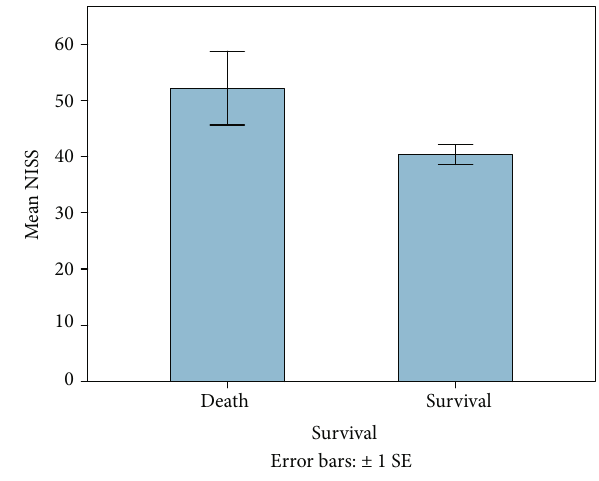
Figure 3: Outcome according to patient ’ s mean age. Patients who died after the traumatic event were older on average when compared to younger polytrauma patients (nonsurvivors n = 8 , mean age 54.9 years; survivors n = 52 , mean age 43.4 years).